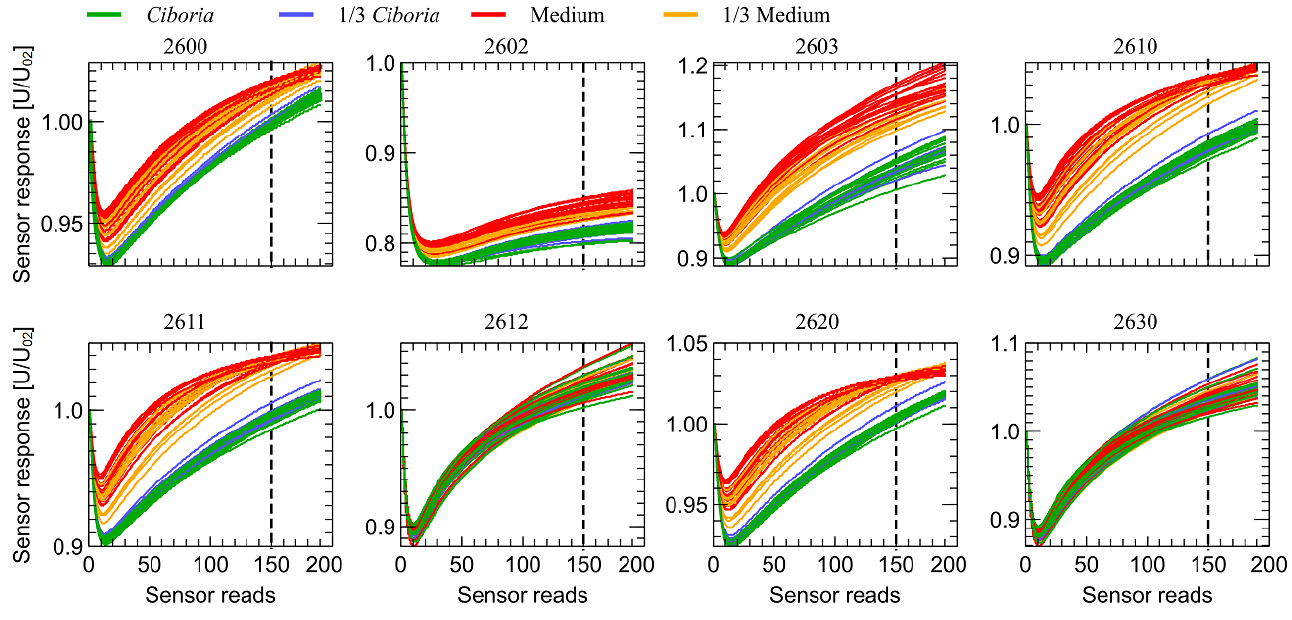
Figure 7. Sensors transient response in the second stage of the observation time (after reduction of the sensor heater voltage), versus time elapsed from the moment of the voltage reduction. The sensor’s response voltage is normalized by the voltage at the beginning of the stage of observation time U 02 . Variants of the measured samples are marked by color lines. The sensor type is indicated above the subfigures. The vertical dotted line indicates the observation moment at which data presented in Figure 9 is